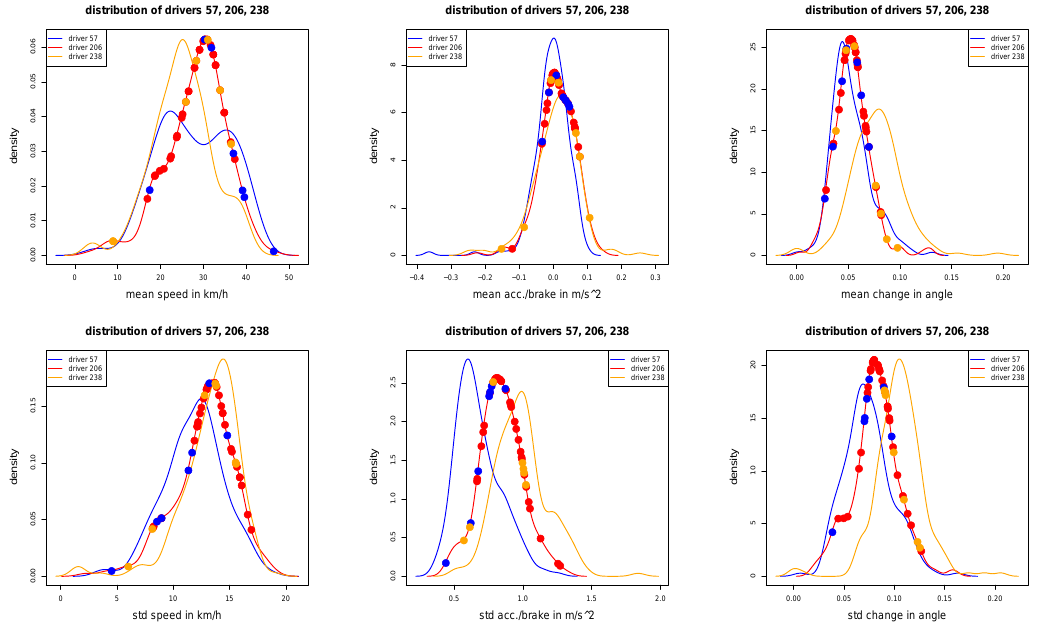
Figure 7. These figures show the same densities as in Figure 5: the dots illustrate the 47 test samples of driver 206: red dots show correctly classified trips, blue and orange dots show misclassified trips (according to the given wrong